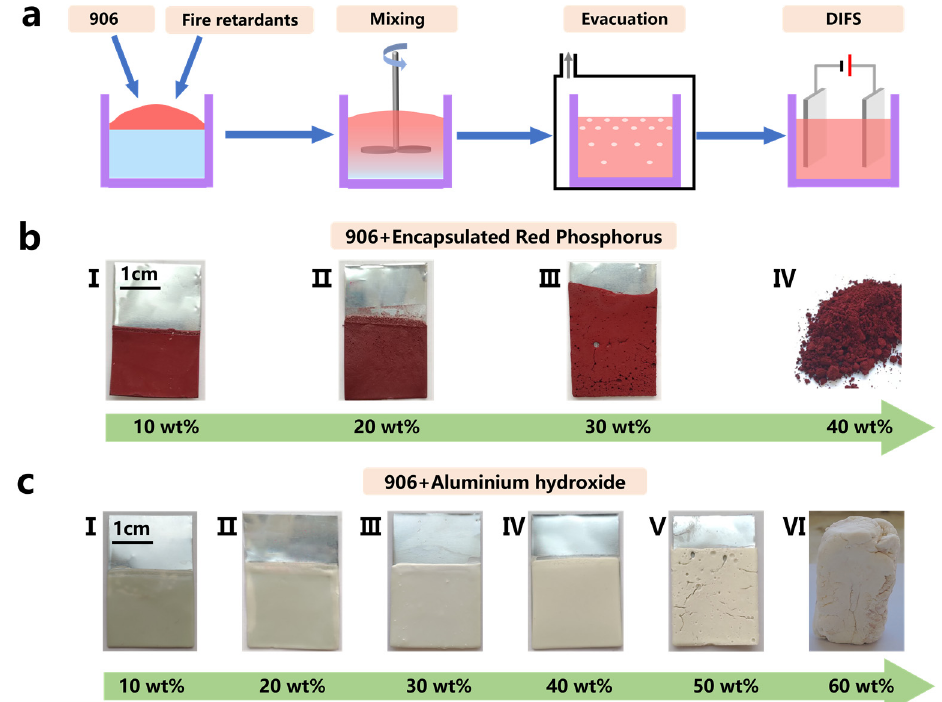
Figure 1. ( a ) Flow chart of the preparation of flame-retardant coating on the metal surface via the DIFS method; ( b ) the flame-retardant coating prepared through the mixing of RP and ATH at different proportions; ( c ) the mixed state.